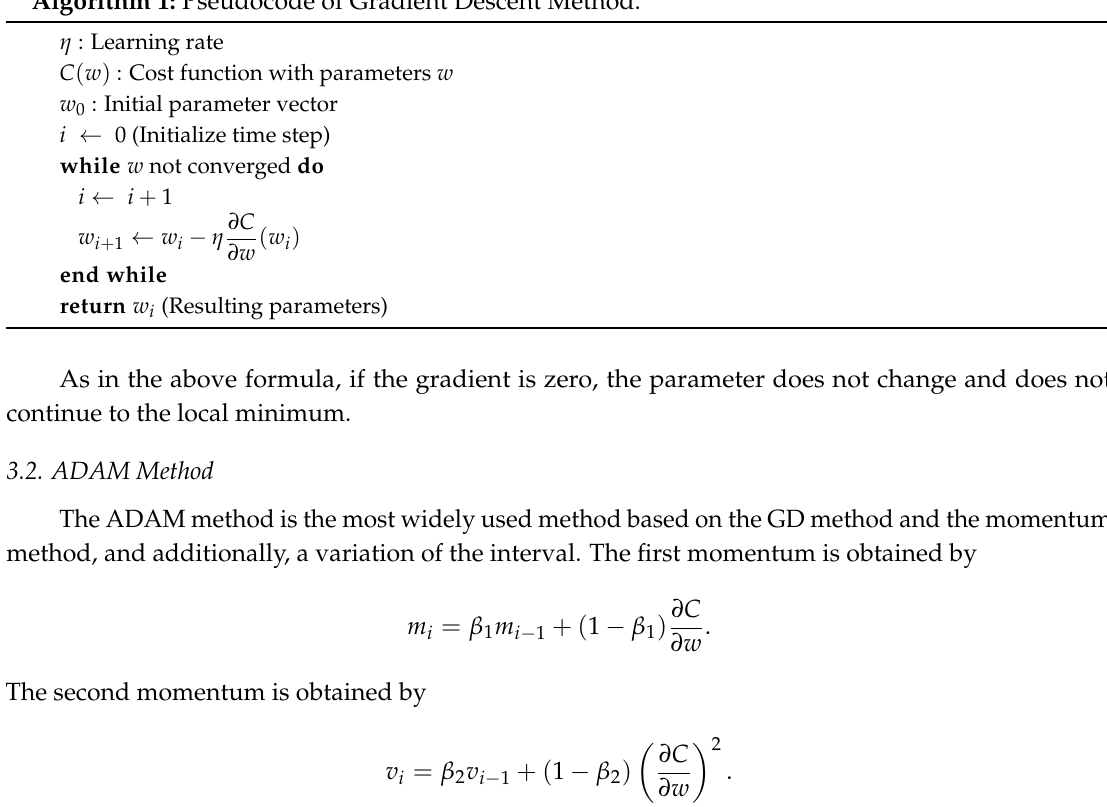
Algorithm 1: Pseudocode of Gradient Descent Method.